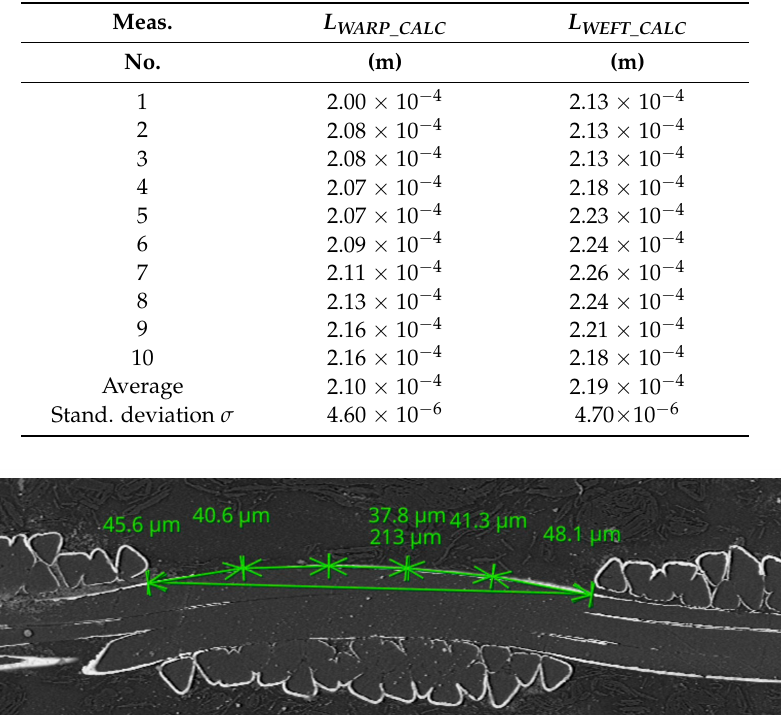
Table 10. The modeling results for L WARP_CALC and L WEFT_CALC − RSKCu+Ni. Meas.